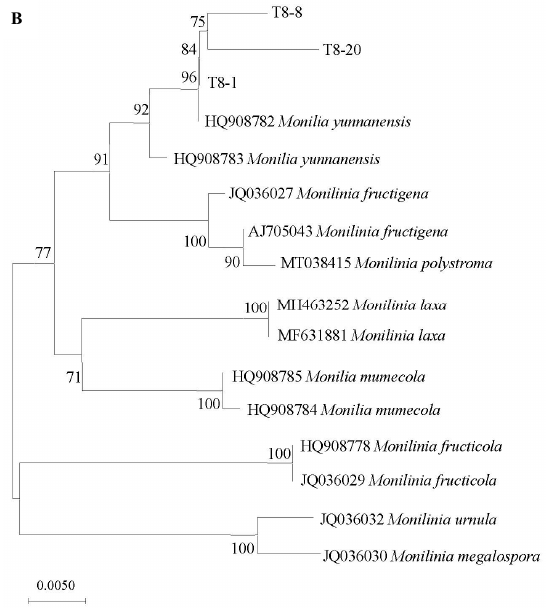
Figure 4. Phylogenetic trees of the representative isolates T8-1, T8-8, and T8-20 were inferred from sequences of TUB2 ( A ) and G3PDH ( B ). The photogenic trees were formed with the neighbor-joining (NJ) method using MEGA version 10.